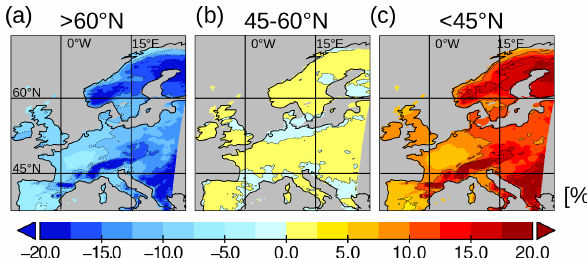
Figure 10. Change in the origin of AR events related to latitudinal bands at 10 ◦ W. (a) North of 60 ◦ N. (b) 45–60 ◦ N and (c) south of 45 ◦ N. The change (difference between 2070–2099 and 1970–1999) for RCP8.5 is